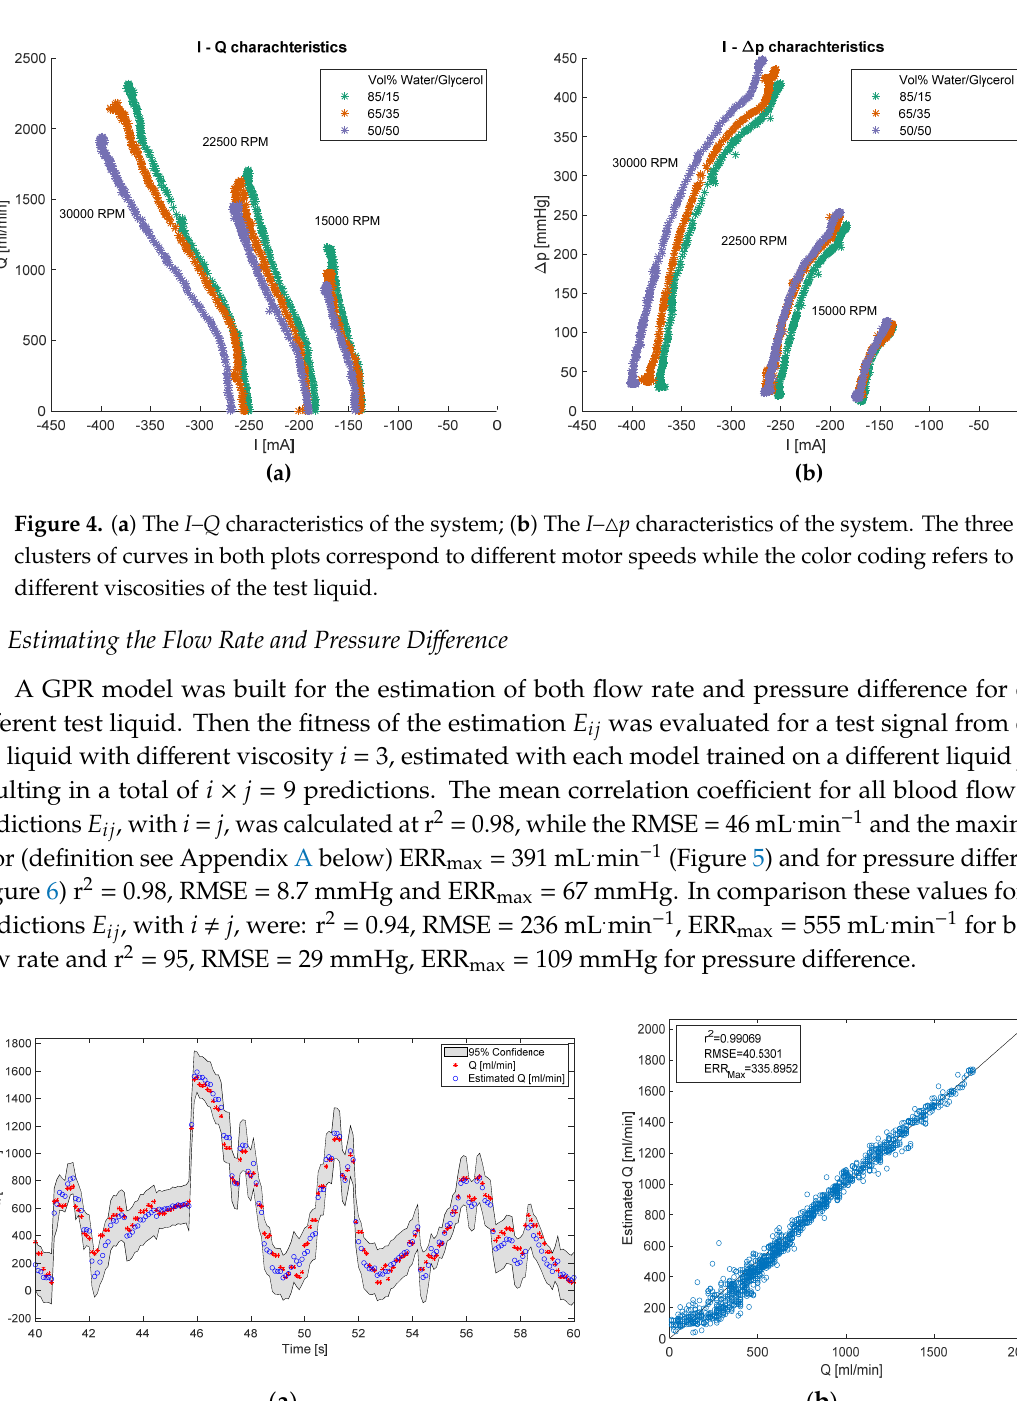
Figure 3. (a) Q– △ p characteristics of the motor ‐ pump assembly used in the experiment. Three clusters of curves can be seen corresponding to three different motor speeds, while the color coding refers to different viscosities of the test liquid; (b) ω –I characteristics of the motor ‐ pump assembly. The motor current is plotted in a boxplot versus motor speed and viscosity of the test liquid.